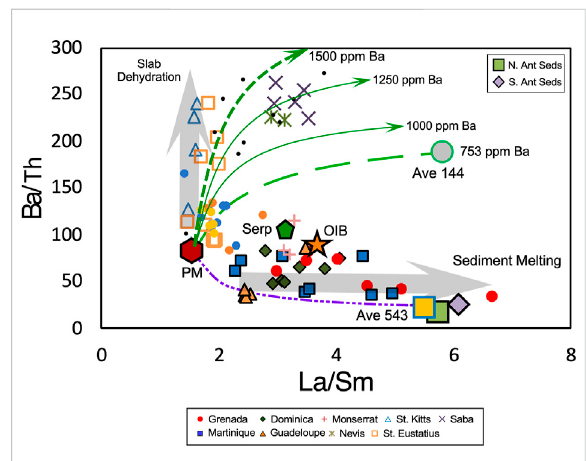
FIGURE 10 Ba/La versus B/La for LAIA samples investigated in this work compared to the compositional fi elds for Central America, the Aleutian Arc, the South Sandwich Arc and Mexico (Ryan and Chauvel 2014). Mantle (PM) as well as North and South Antilles Sediment (light green square and purple diamond) reported by Plank and Langmuir (1998) are shown. Serpentines average 12 – 37 for Ba/La and 105 – 2000 for average B/La (Savov Bouvier et al., 2010 respectively) show that some samples seem to be a mixture of mantle and a higher boron component while northern island seem to trend towards high Ba/La along a Central American “ trajectory. ” Figure modeled after Ryan and Chauvel 2014.